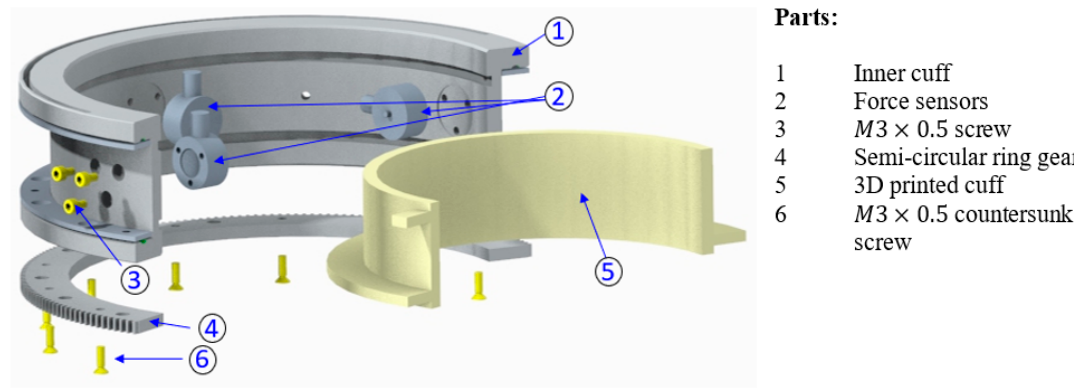
Figure 8. Exploded view of the upper arm sensorized cuff assembly.